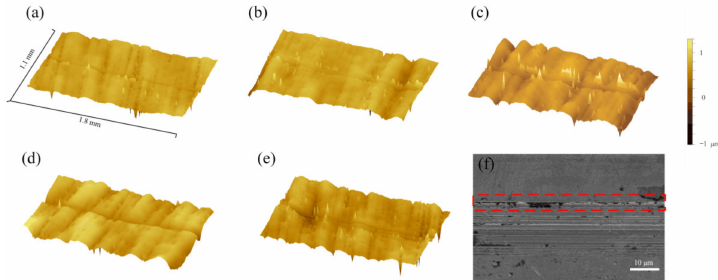
Figure 7. Three-dimensional morphology reconstruction of wear tracks ( a ) 0.6 Pa, ( b ) 0.9 Pa, ( c ) 1.2 Pa, ( d ) 1.5 Pa, ( e ) 1.8 Pa, ( f ) FESEM track graph of 1.8